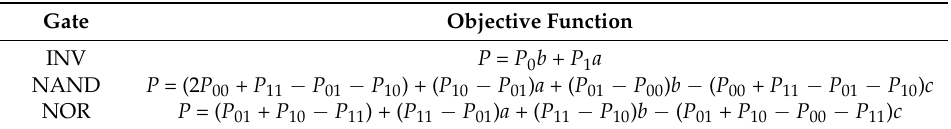
Table 3. ILP objective function for leakage power of logic gates.